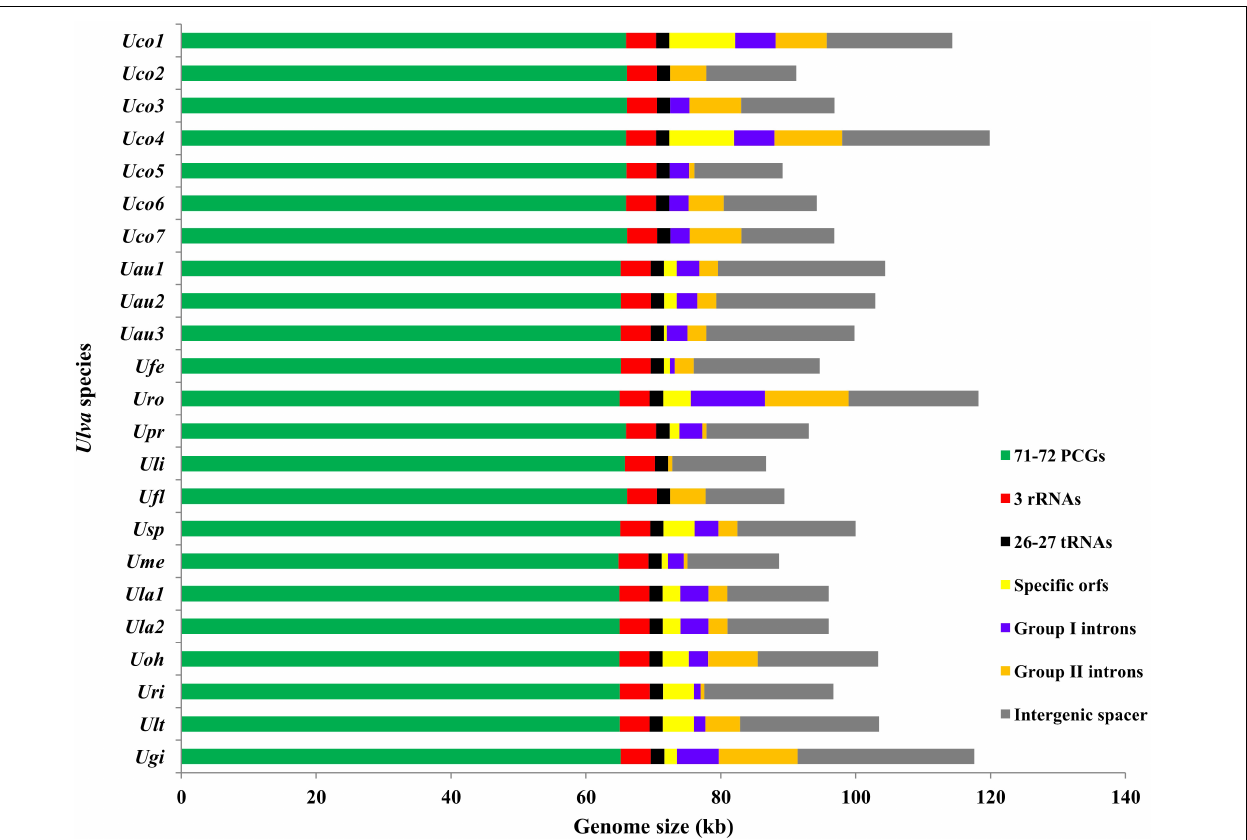
FIGURE 1 | Contributions of conserved 71-72 PCGs, 3 rRNA genes (rRNAs), 26-27 tRNA genes (tRNAs), genome-specific free-standing orf s, group I introns, group II introns, and non-coding intergenic spacer regions in the 23 Ulva chloroplast genomes. The PCG proportion in Uco5 was adjusted due to the faulty assembly of some PCGs ( rpoA , rpoB , rpoC1 , and rpoC2 ). Horizontal bars represented the size of the Ulva